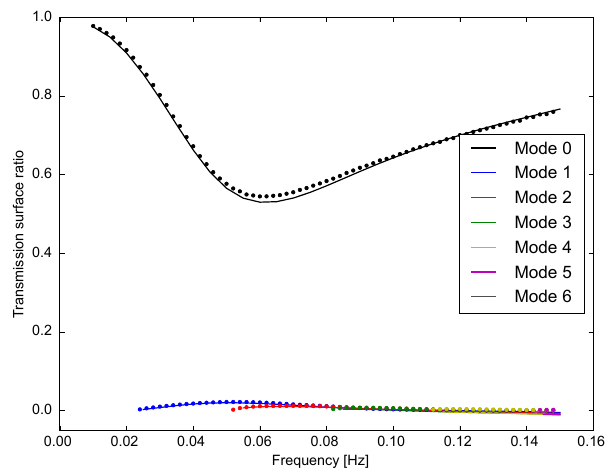
Figure 4. Transmission surface ratio obtained by the GF method (solid lines) and FD calculations (dots), for an incident Rayleigh wave fundamental mode propagating through model L in the for- ward direction. Note that the conversion to higher modes is much weaker than in the Love wave case, but the SWRT result is in good agreement with the FD result.